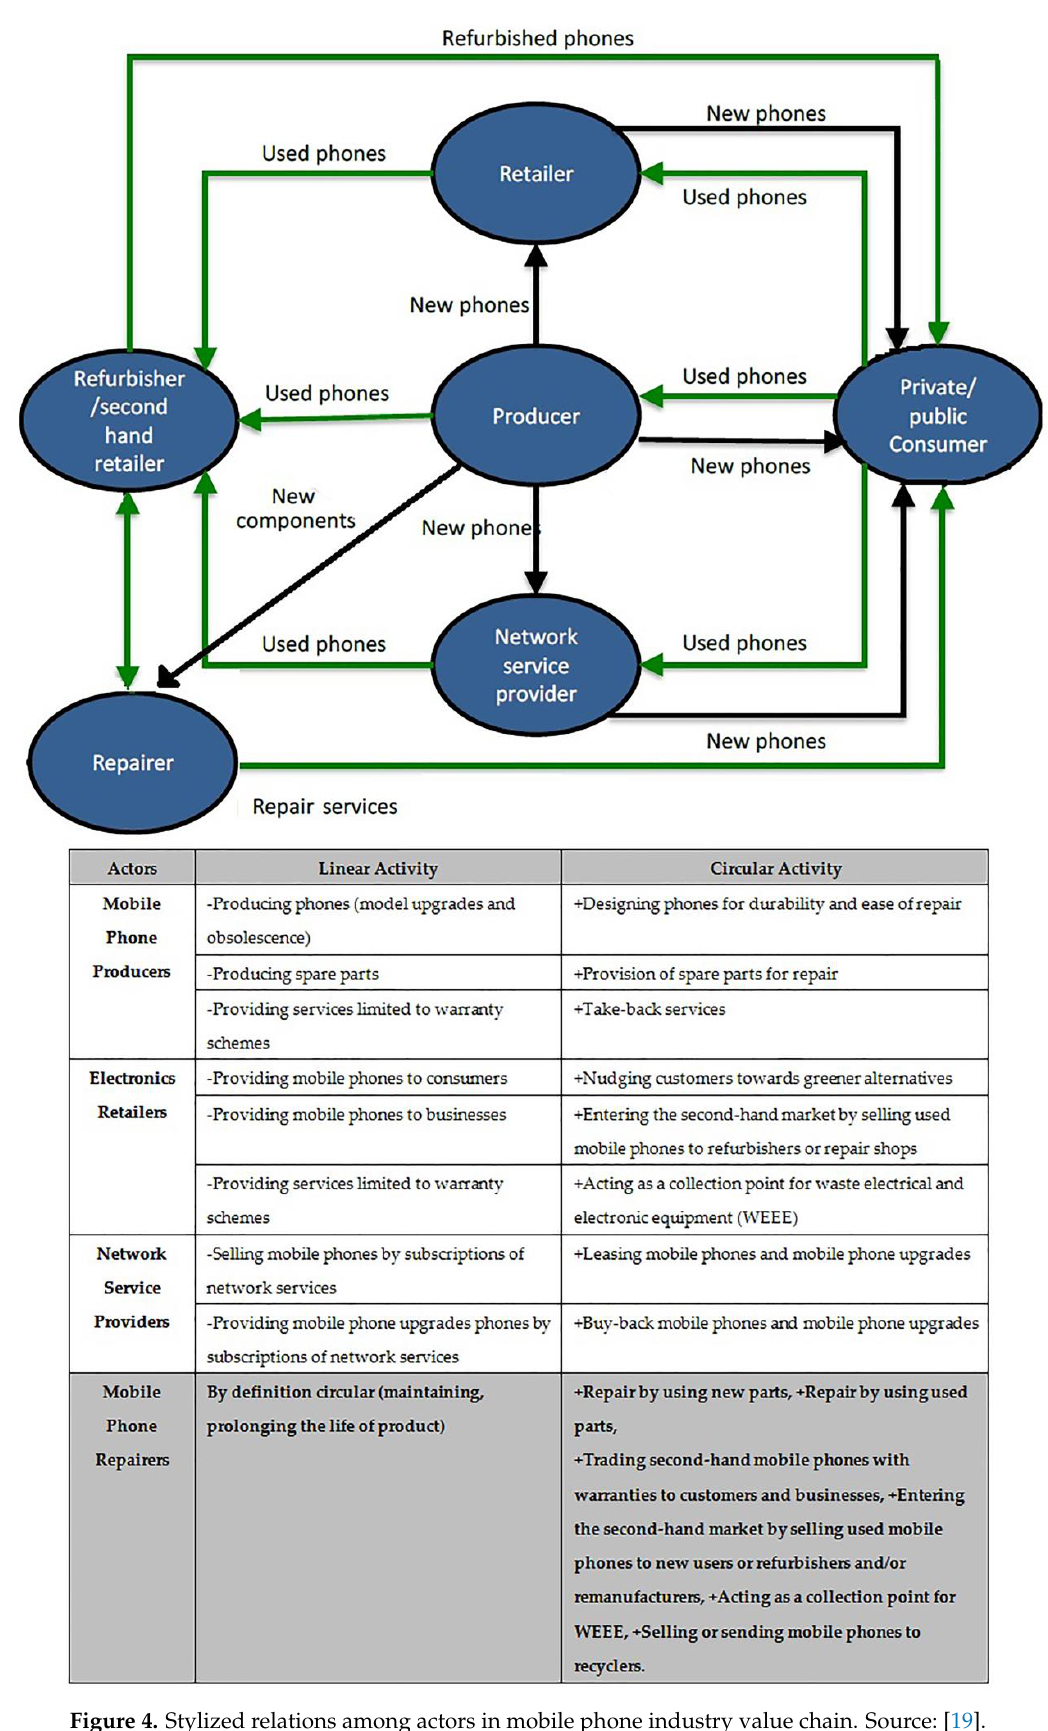
Figure 4. Stylized relations among actors in mobile phone industry value chain. Source: [19] .